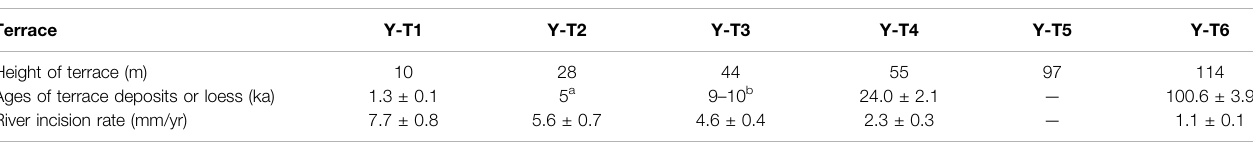
TABLE 3 | River incision rates at the river mouth (transect